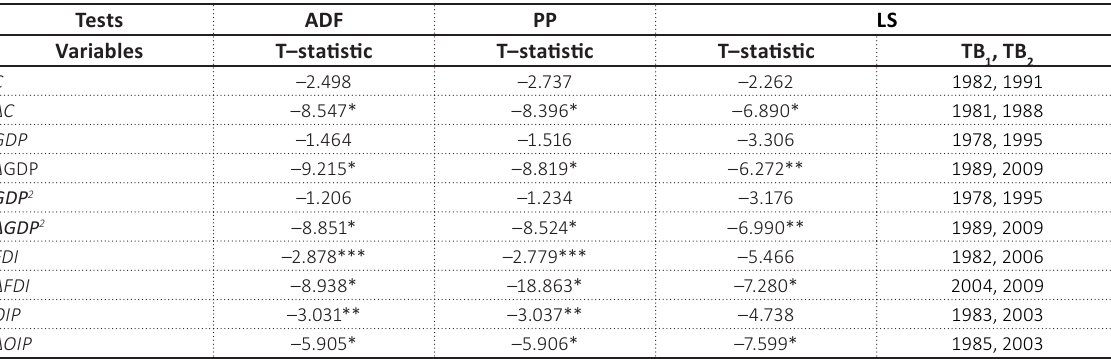
Table 1. Unit root